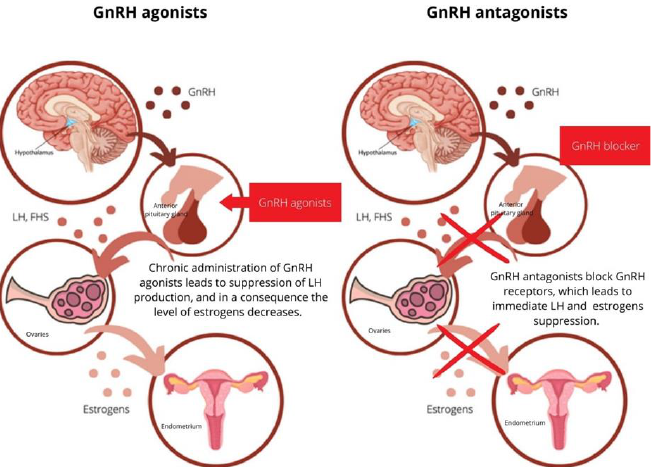
Figure 1. Mechanism of action of GnRH analogs. Prolonged activation of GnRH receptors by GnRH agonists leads to gonadotropin secretion suppression. As a consequence, the secretion of estrogen is also decreased. Comparatively, the mechanism of GnRH antagonists is competitive in the occu- pancy of the GnRH-receptor. As a result of the blockade of GnRH receptors, the suppression of gonadotropin and estrogen is observed.